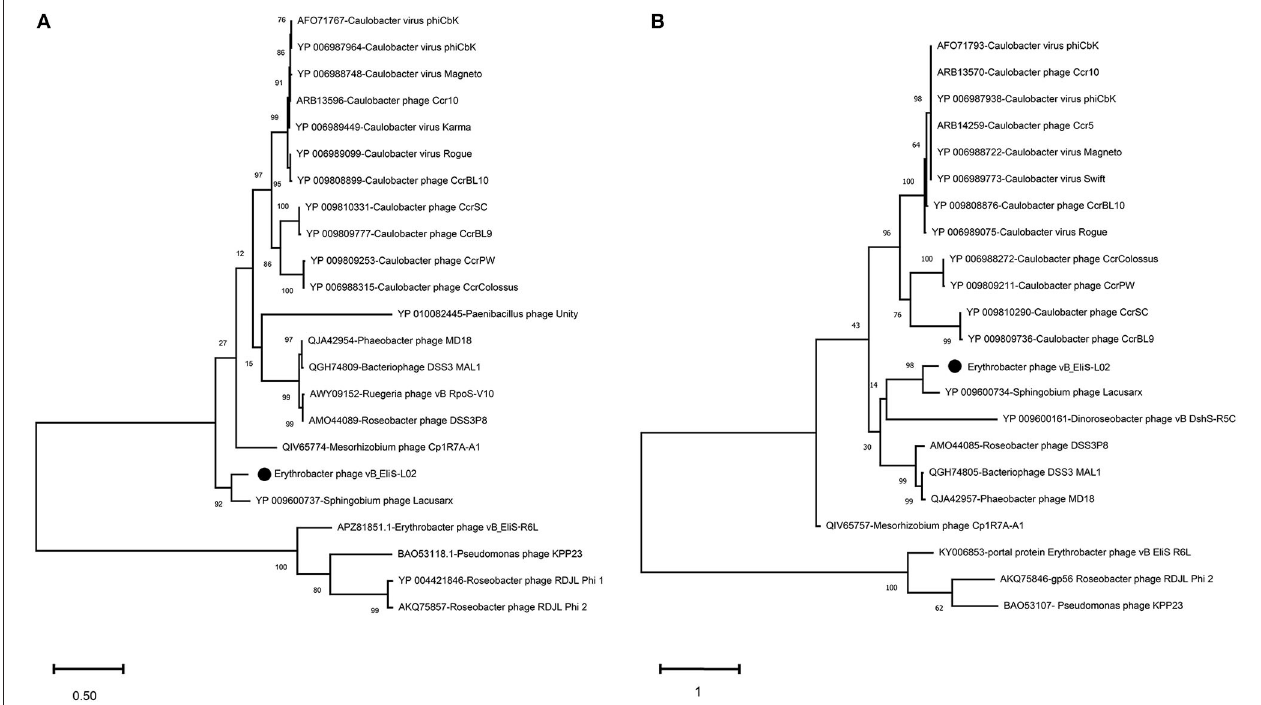
FIGURE 4 | Maximum-likelihood phylogenetic trees based on (A) major capsid protein and (B) portal protein.